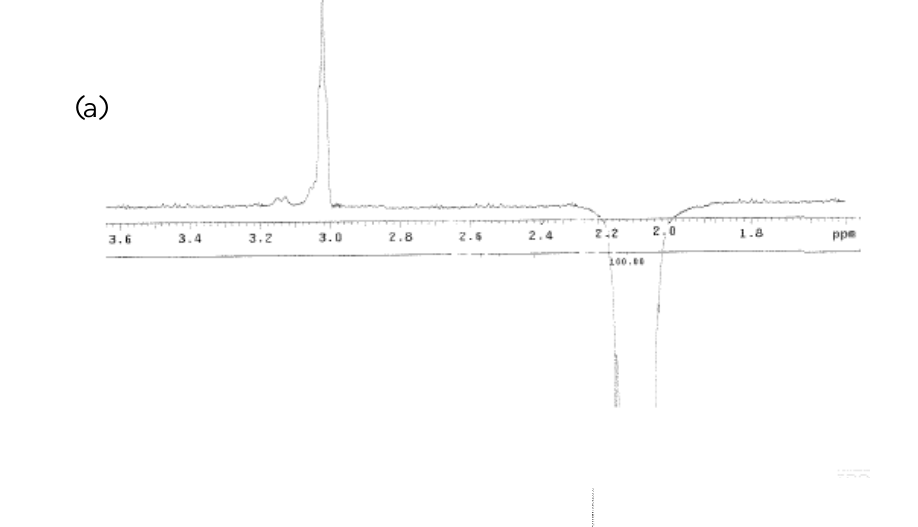
Figure 3. (a) 1D NOE NMR for CH at 5-position, with irradiation of neighboring CONH 3 proton in compound ( 3 ) recorded at 400 MHz in DMSO- d . (b) 1D NOE NMR for CH 6 2-position, irradiated with neighboring CONH proton in compound ( 3 ) recorded at 400 MHz, in DMSO- d 6